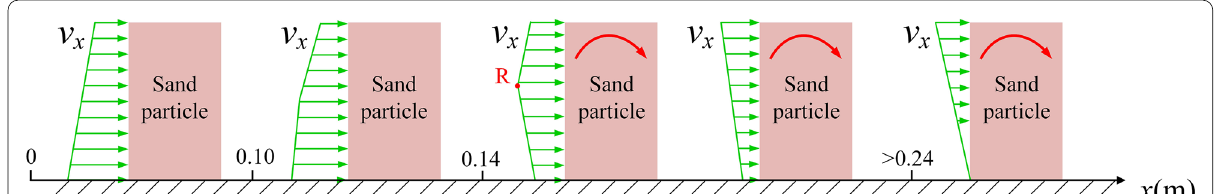
Figure 13 Schematic diagram of the velocity for sand particles in the x